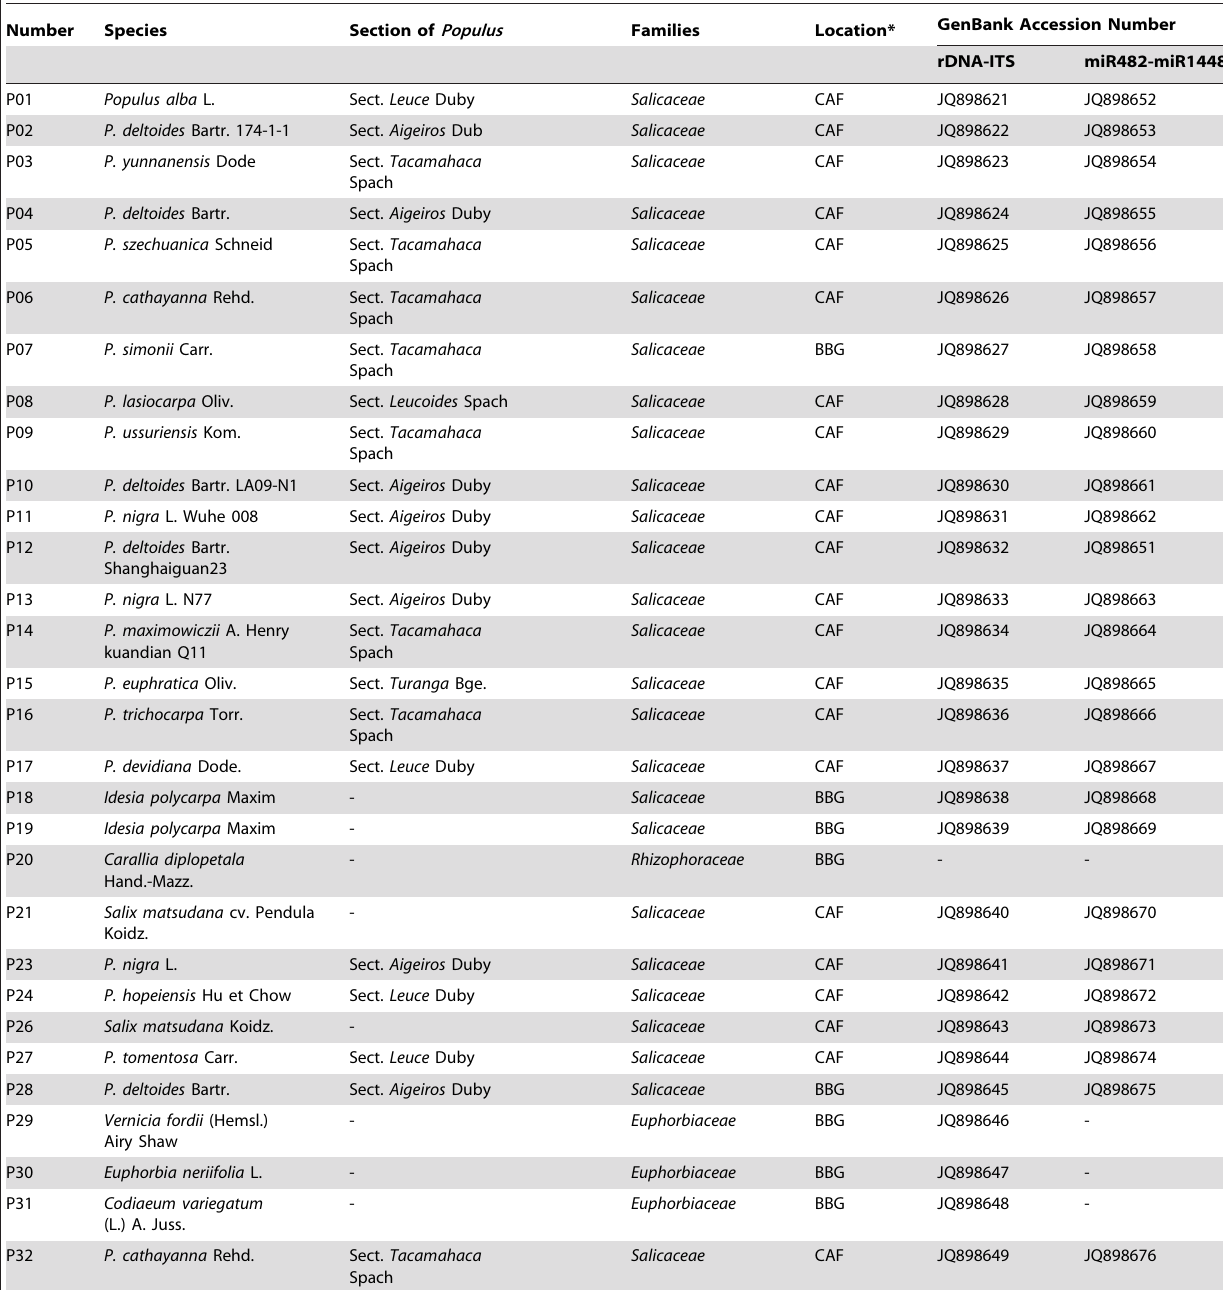
Table 1. Plant materials used in this